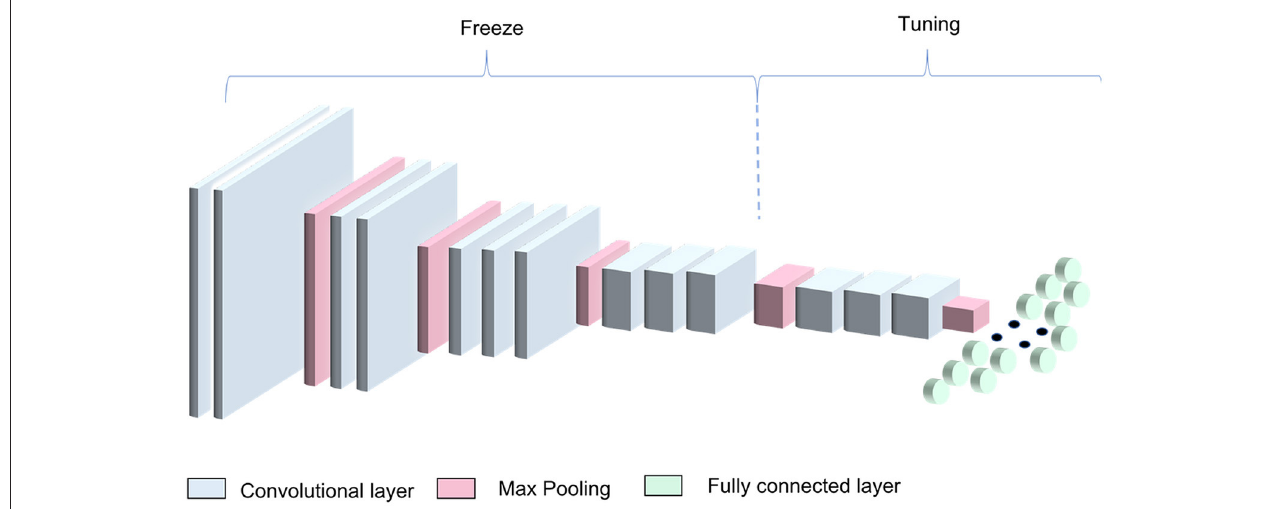
FIGURE 2 | VGG16 transfer-learning strategy. The algorithm was obtained by freezing the first four blocks of the VGG16 pretrained on the ImageNet dataset and training the remaining blocks along with the dense layers.